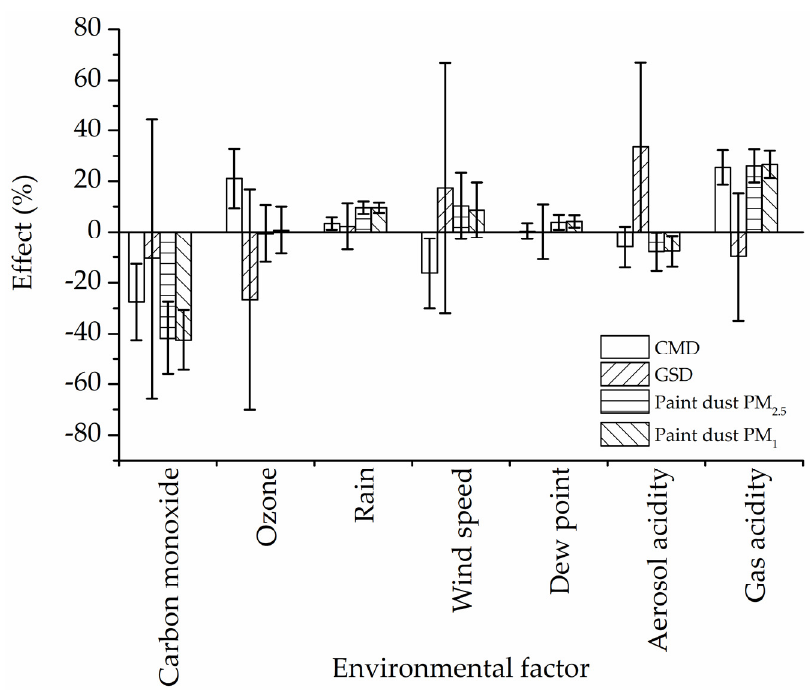
Figure 6. Effect (%) of environmental weathering conditions on paint dust PM 2.5 , PM 1 , CMD, and GSD.